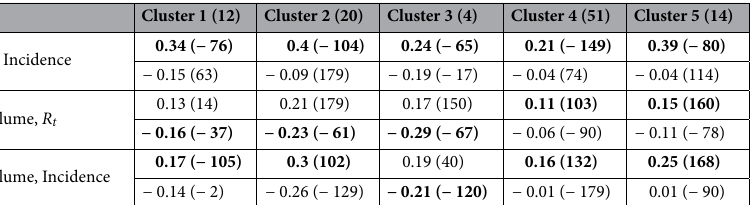
Table 2. Key descriptive statistics across clusters as at 15 May 2020. This table shows the maximum positive correlation and the minimum negative correlation among the daily policy volume, the daily effective reproduction number and the daily incidence count for each cluster identified in “Patterns of initial public health interventions and effective reproduction number”. We highlighted the correlation with the highest absolute value in each section and cluster. The values in the brackets record the offset days associated with the maximum or minimum